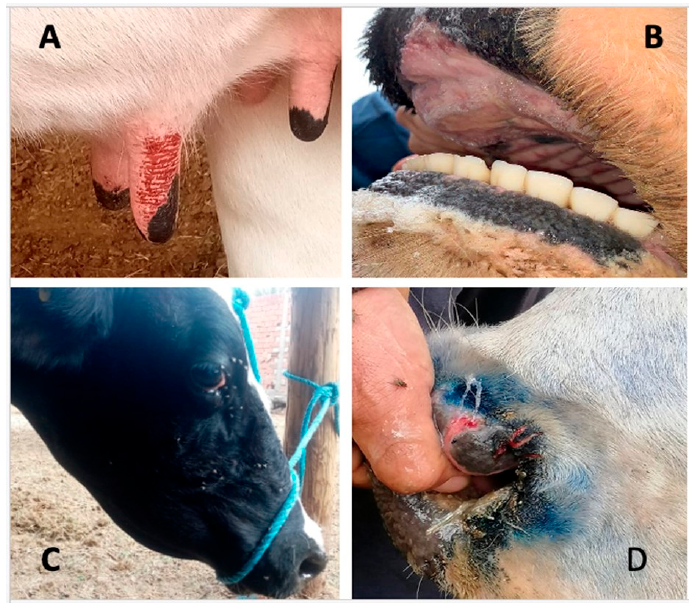
Figure 1. Clinical signs in cattle. ( A ) Teat erosions; ( B ) oral congestion and erosions; ( C ) submandibular oedema, conjunctivitis, and lacrimation; ( D ) nasal discharge and mucosal erosion. Reprinted/adapted with permission from the Tunisian Veterinary Services. Copyright 2021, copyright Dr Bel Hadj Mohamed Bassem (A, C); Dr Nadia Hemriti (B); Dr Meriem Ben Abdallah (D)”.